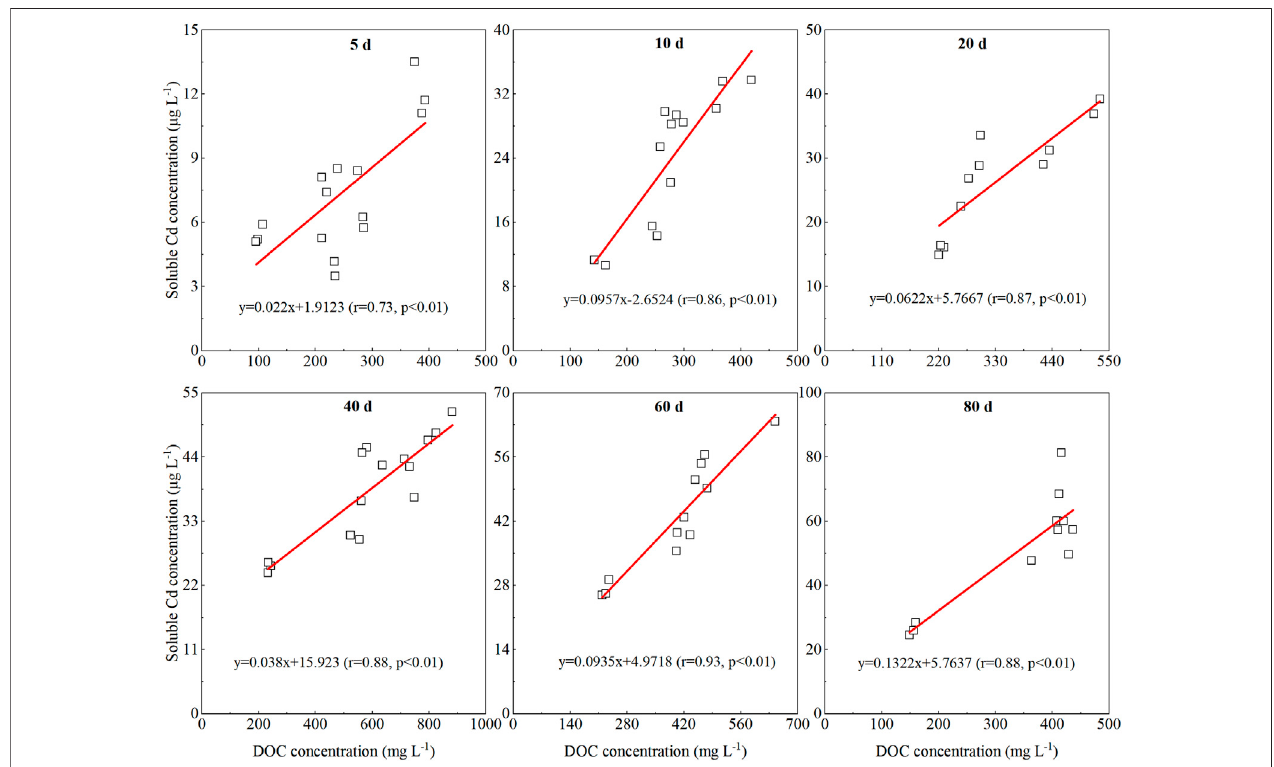
FIGURE 5 | Correlations between soluble Cd concentration and DOC content in soil leachate at different decomposition phases of wheat straw (5, 10, 20, 40, 60, and 80 days).